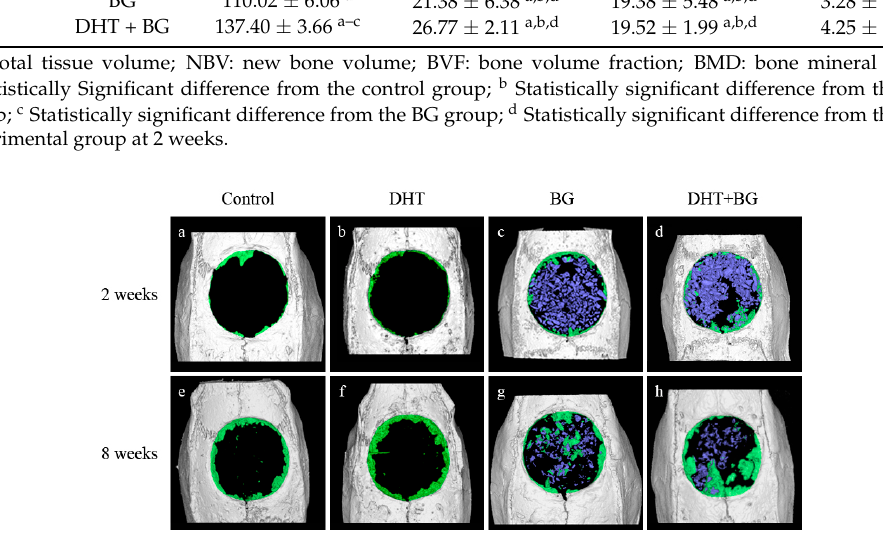
Figure 1. Three-dimensional reconstruction images obtained at 2 and 8 weeks after surgery. ( a , e ) Control group; ( b , f ) DHT membrane group; ( c , g ) BG group; ( d , h ) DHT + BG group. Gray: mother bone; green: new bone; purple: bone graft material.